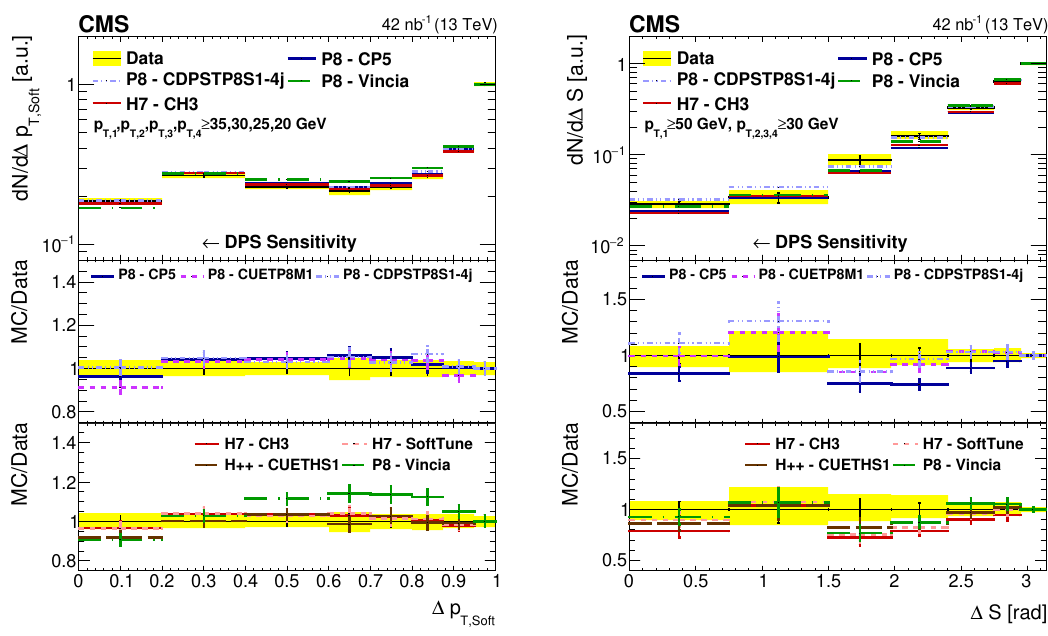
and ∆ S distributions from data to different pythia 8 (P8), Figure 5 . Comparison of the ∆ p T,Soft herwig++ (H++), and herwig 7 (H7) tunes in Region I and Region II, respectively. All distribu- tions have been normalized to regions where a reduced DPS contribution is expected. The error bars represent the statistical uncertainty, and the yellow band indicates the total (statistical+systematic) uncertainty in the